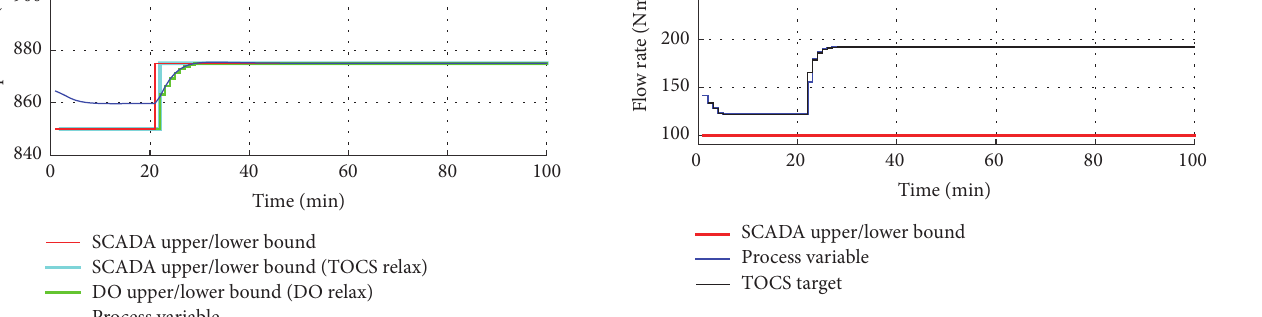
Figure 12: Zone 5 fuel flow rate trends.